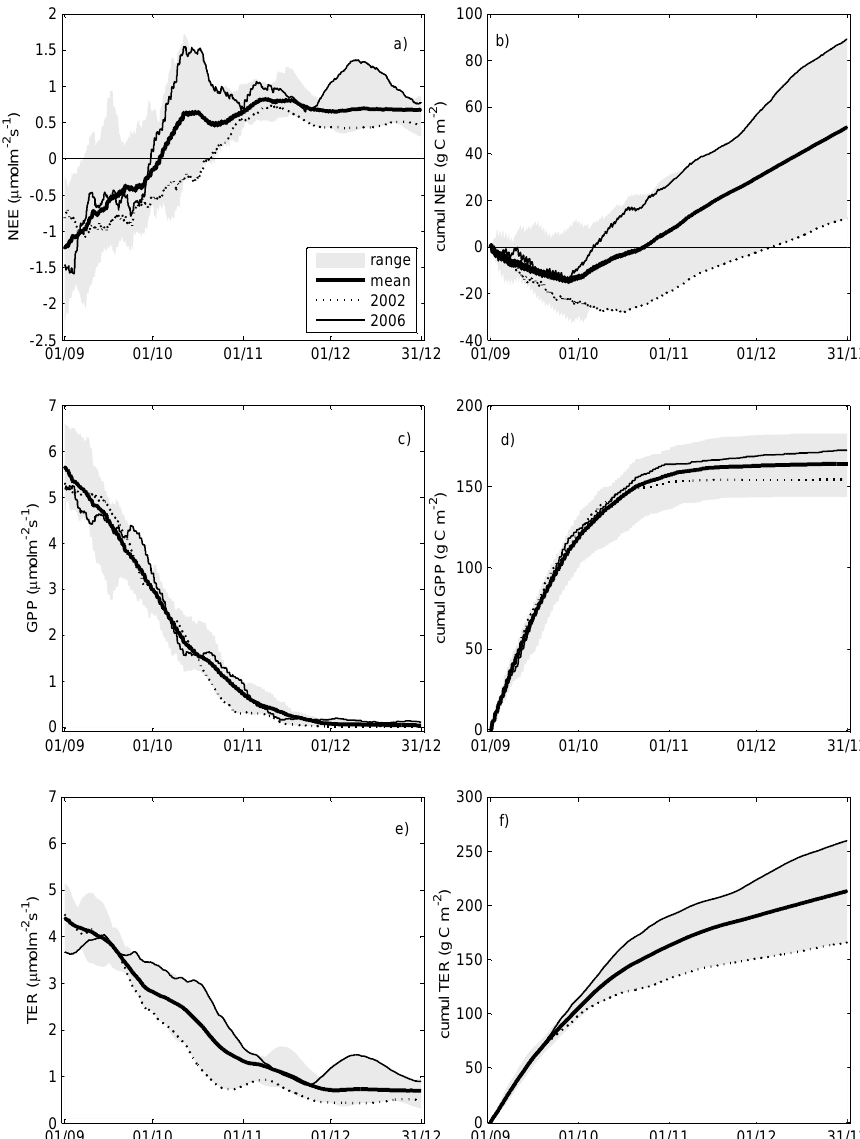
Fig. 3. Net ecosystem exchange (NEE), gross primary productivity (GPP) and ecosystem respiration (TER) as 14-day running mean (left) and their cumulative values (right). The symbols are as in Fig.